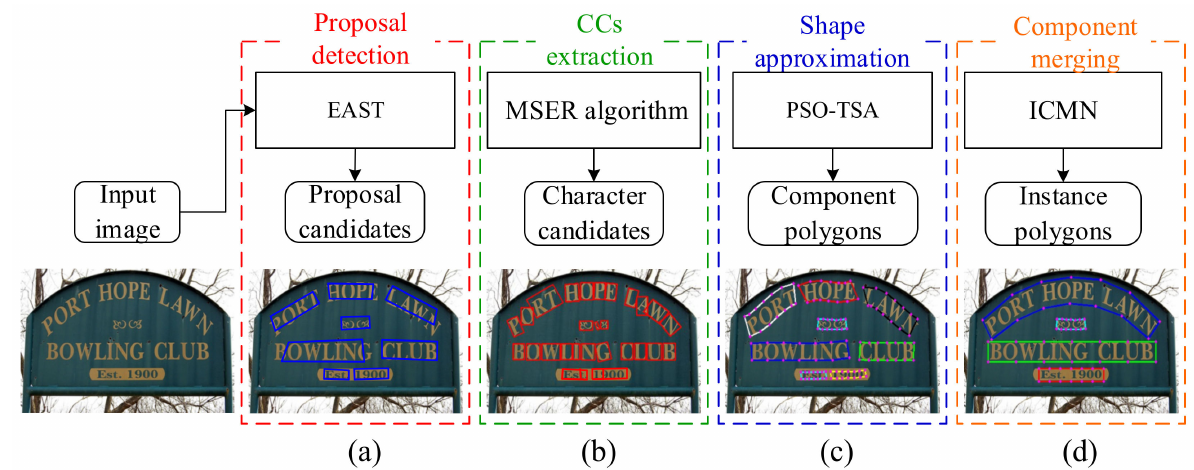
Figure 1. Illustration of the overall pipeline, ( a ) proposal detection module, ( b ) CCs extraction module, ( c ) shape approxi- mation module and ( d ) component merging